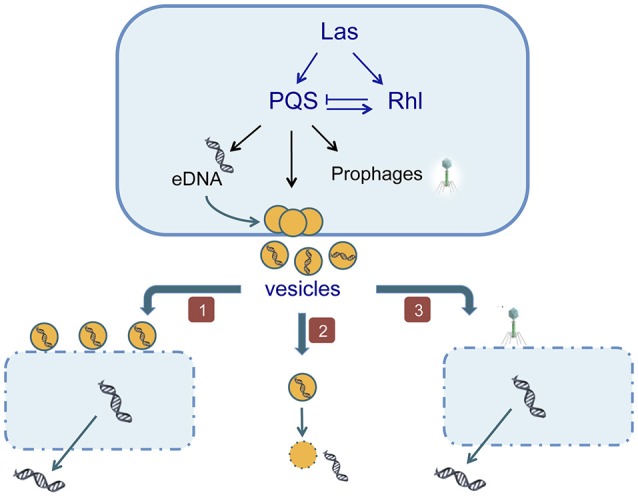
The eDNA production in Pseudomonas aeruginosa is induced by QS signals. (1) Vesicles cause lysis of other cells of the same culture; (2) the secreted vesicles carry the eDNA across the membrane to the extracellular medium; (3) QS activates the induction of prophages causing the death of neighboring cells.